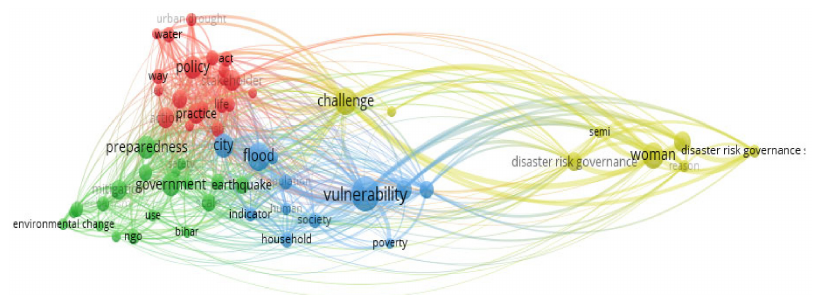
Figure 1. Keywords found in the articles retrieved for this research.